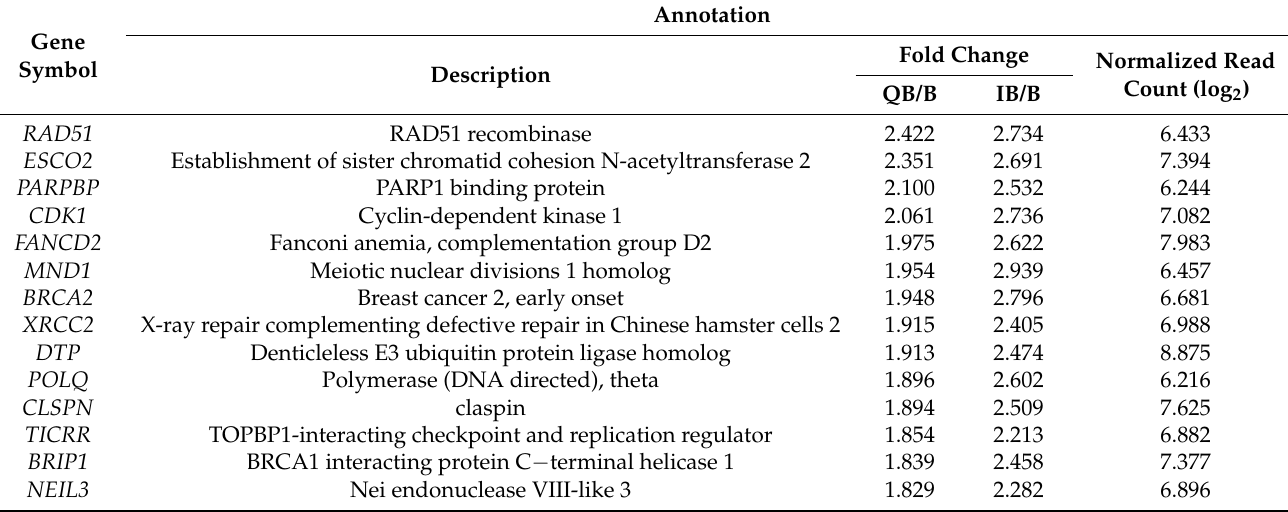
Table 1. Top 15 differentially expressed genes related to DNA